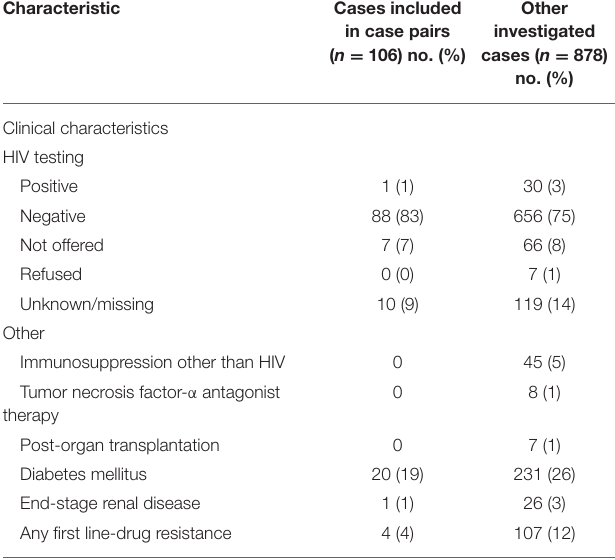
TABLE 1 | Demographic, molecular, and clinical characteristics of patients in the analytic data set of genotype-matched TB source–secondary case pairs vs. other investigated cases in Los Angeles County, California,